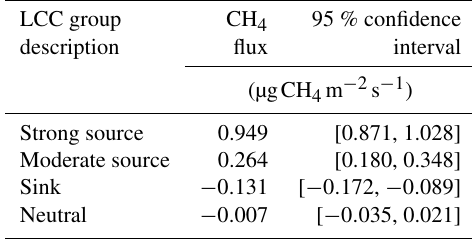
Table 5. Estimated CH 4 fluxes for the aggregated land cover